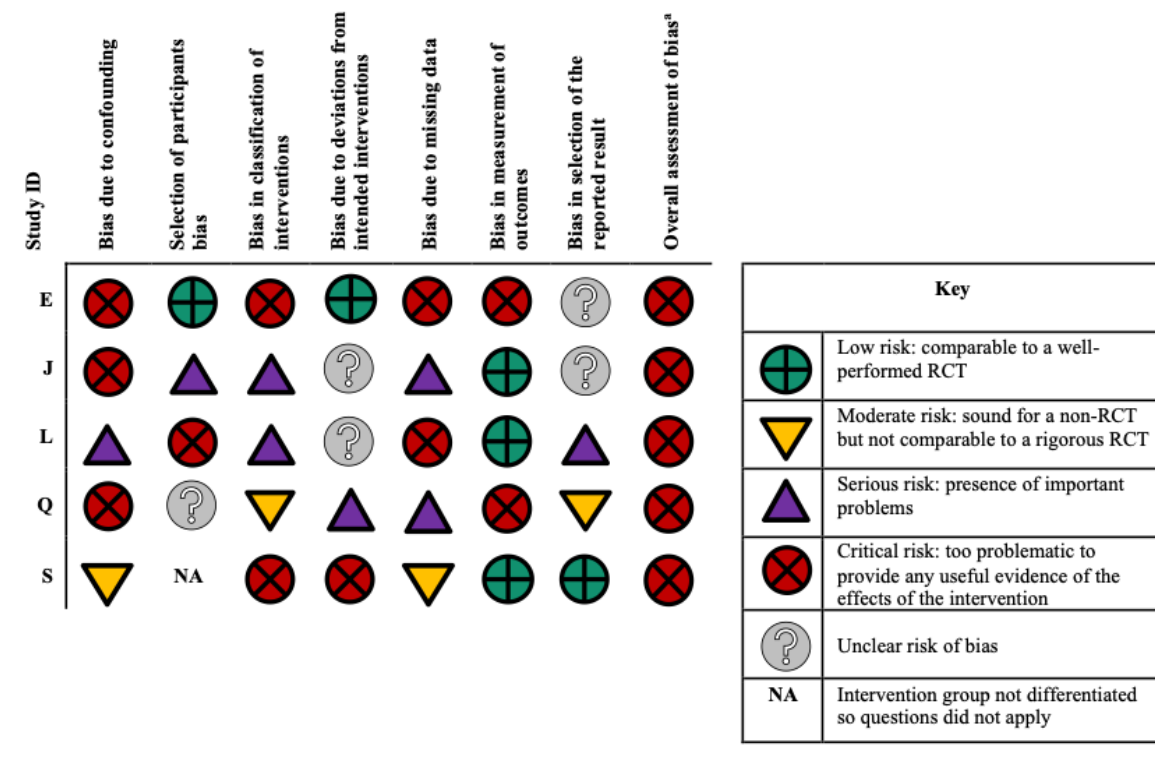
Figure 3. Risk of bias assessment for the nonrandomized controlled trial (RCT) studies. a Overall risk of bias: equal to the most severe level of bias found in any